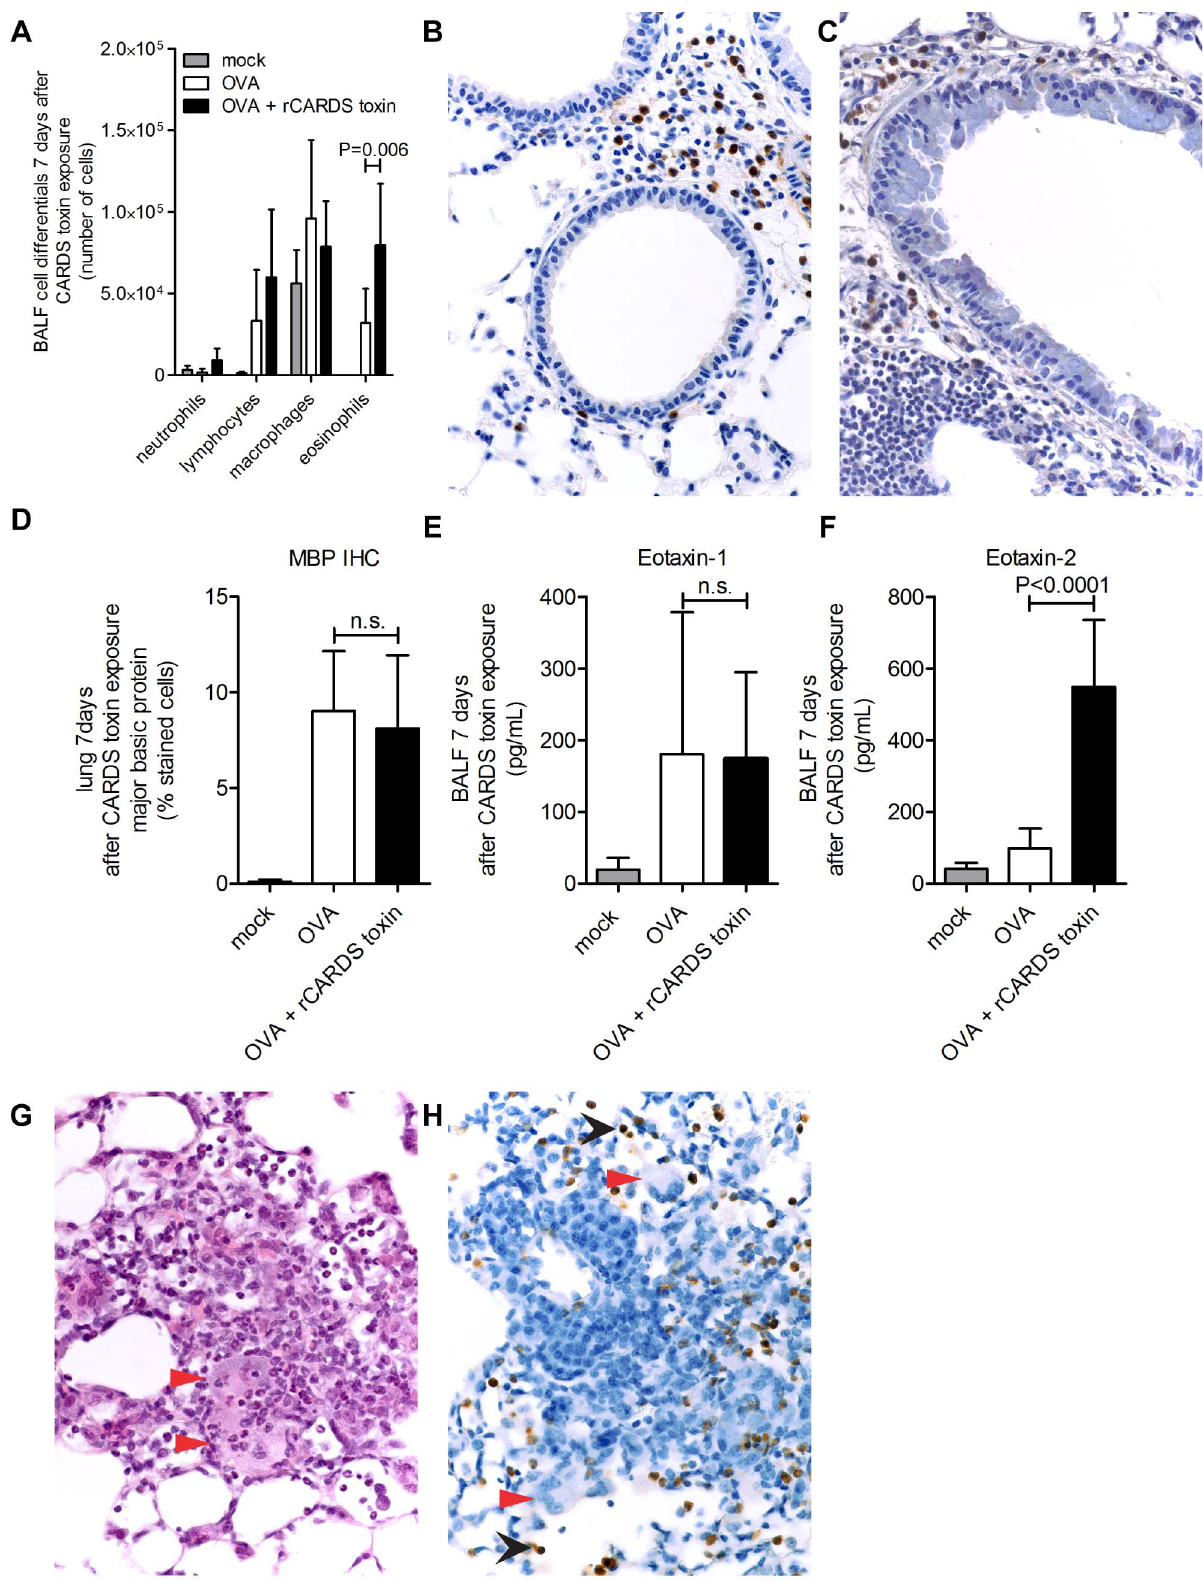
Figure 2. rCARDS toxin exacerbates eosinophilia . A) Cellular differentials from BALF on day 7 after exposure to CF or rCARDS toxin. Increased eosinophilia is seen at day 7 (p=0.006). B-C) Eosinophils at peribronchiolar lesions of OVA (B) or OVA + rCARDS toxin (C) detected by immunohistochemistry with anti-MBP. Brown color depicts positive staining for eosinophil MBP. Original magnification 40x. D) Quantification of